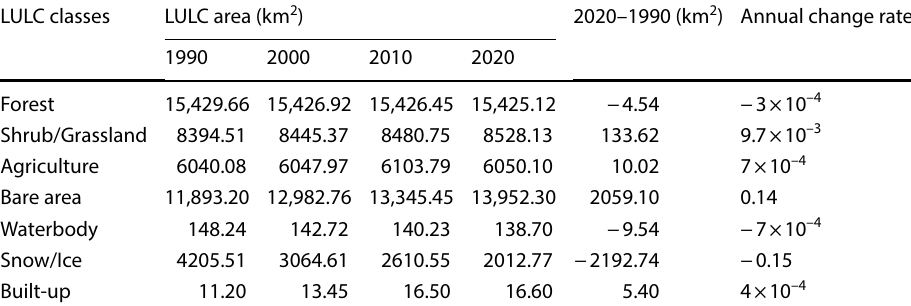
Table 5 LULC and its change in the